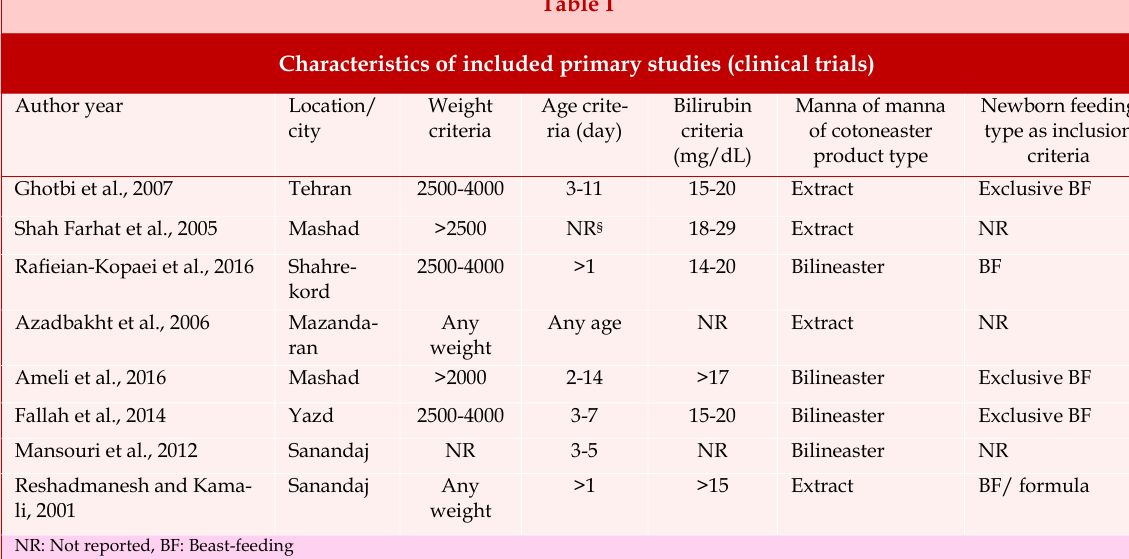
Characteristics of included primary studies (clinical